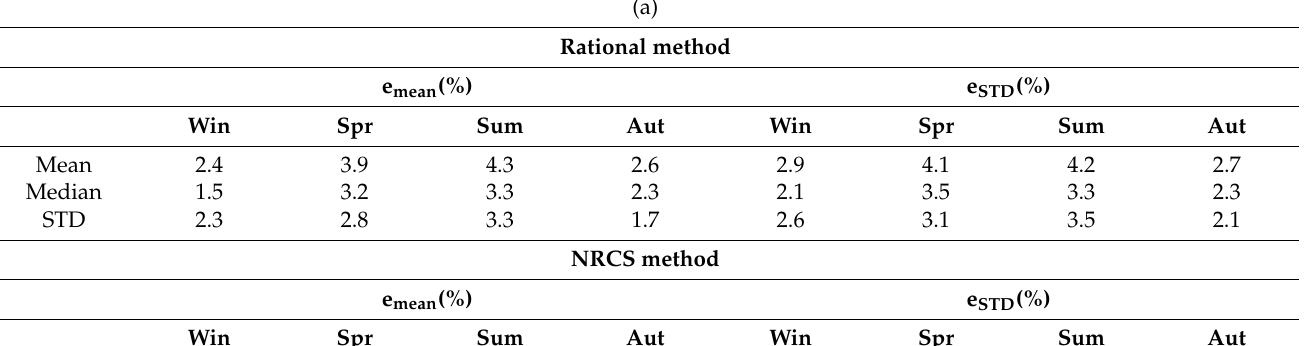
Table 4. (a) Mean, median, and standard deviation (STD) of the errors on the mean (e mean ) and standard deviation (e STD ) evaluated in the case of synthetic runoff profiles, for the Patern ò case study. (b) Mean, median, and standard deviation (STD) of the errors on the mean (e mean ) and standard deviation (e STD ) evaluated in the case of synthetic runoff profiles, for the Busachi case study. (a) Rational method e mean (%) e STD